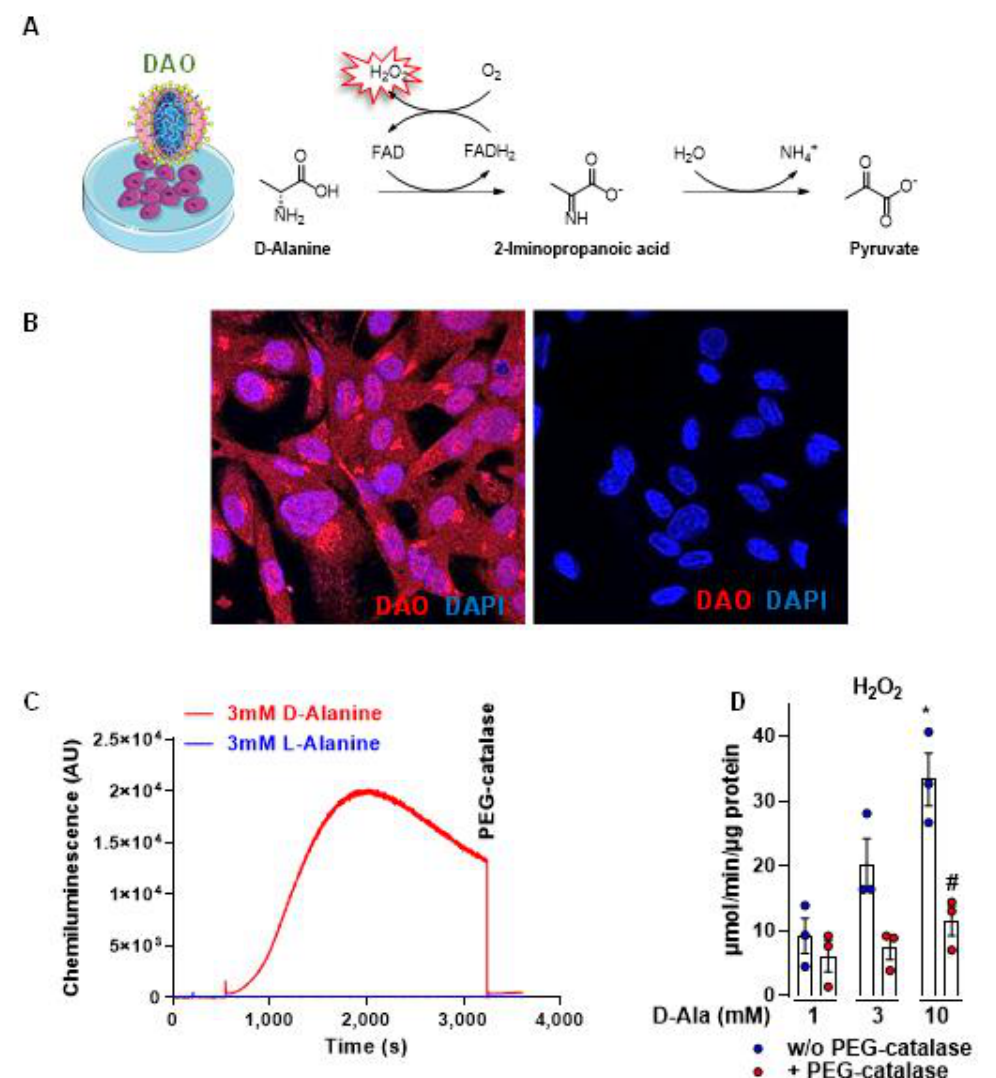
Figure 1. Generation and characterization of DAO as a chemogenetic approach to study the met- abolic and transcriptomic response to intracellular H 2 O 2 in HUVEC. ( A ) Lentiviral overexpression of human D-amino acid oxidase (DAO) and its chemical reaction. ( B ) Immuno-fluorescence for DAO in HUVEC-DAO ( left ) and HUVEC-CTL (empty vector, right ). ( C ) H 2 O 2 measurements in HUVEC using Luminol/HRP and ( D ) Amplex red®/HRP assay * p < 0.05 10 mM D-Ala versus 1 mM D-Ala; # p < 0.05 10 mM D-Ala plus vs 10 mM D-Ala minus PEG-catalase. One-way-ANOVA with Bonferroni